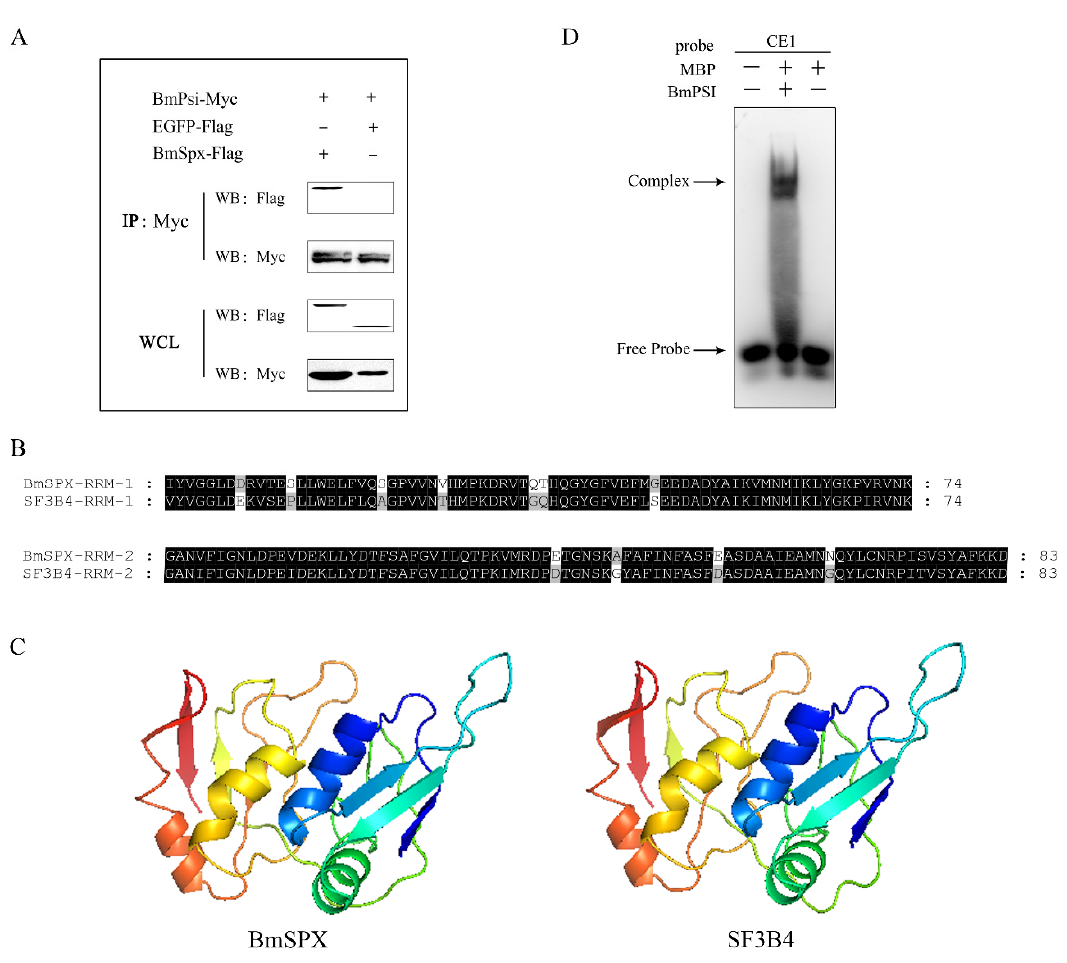
Figure 3. BmSPX may participate in alternative splicing of Bmdsx as a splicing factor. ( A ) Co- immunoprecipitation (CO-IP) experiment between BmSPX and BmPSI. IP:Myc indicates that CO-IP experiment was carried out with Myc antibody. WB:Myc and WB:Flag indicate that Western Blot experiments were carried out with Myc antibody and Flag antibody, respectively. WCL, Whole cell lysate. ( B ) Sequence alignment of the RRM domain between BmSPX and its homologous protein SF3B4. RRM, RNA recognition motif. Black and grey indicate identical and similar amino acids, respectively. ( C ) The tertiary structure of BmSPX and SF3B4. ( D ) The electrophoretic mobility shift assay (EMSA) experiment between BmPSI and RNA probe CE1. MBP, Maltose binding